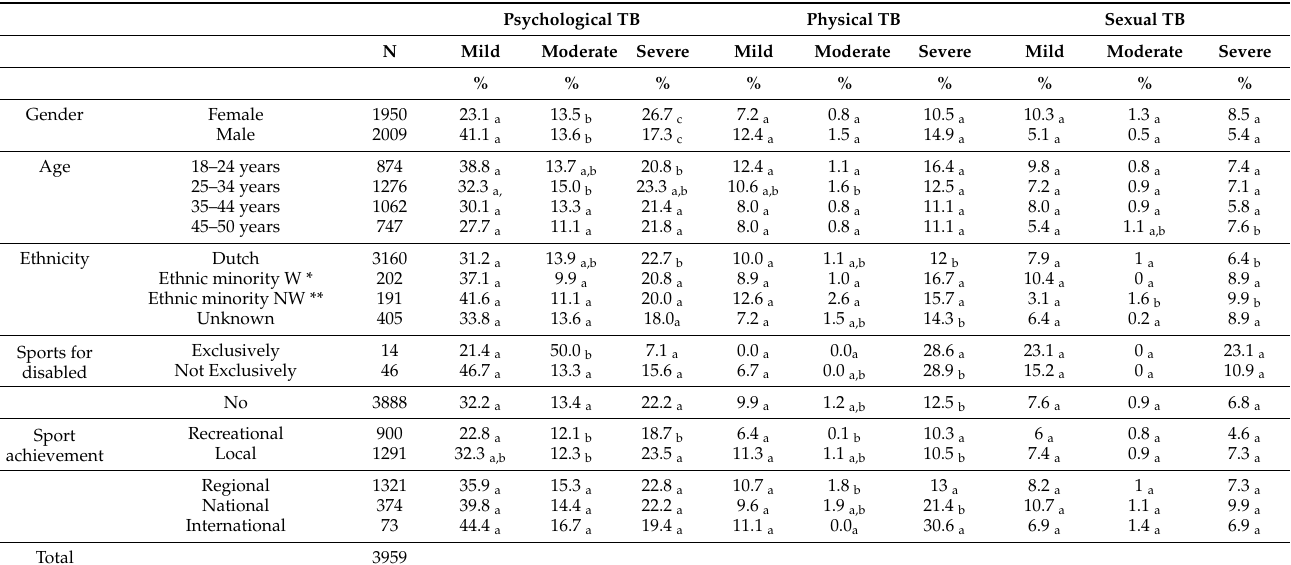
Table 5. Expert-rated severity of the sport-related childhood transgressive behavior (TB) clas- sified according to gender, current age, ethnicity, participation in disabled sports, and highest sporting achievement.